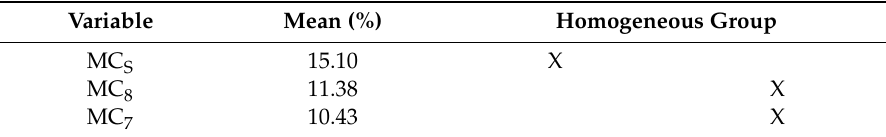
Table 6. Multiple Range Tests for MCs, MC8 and MC7. Method: 95.0 percent